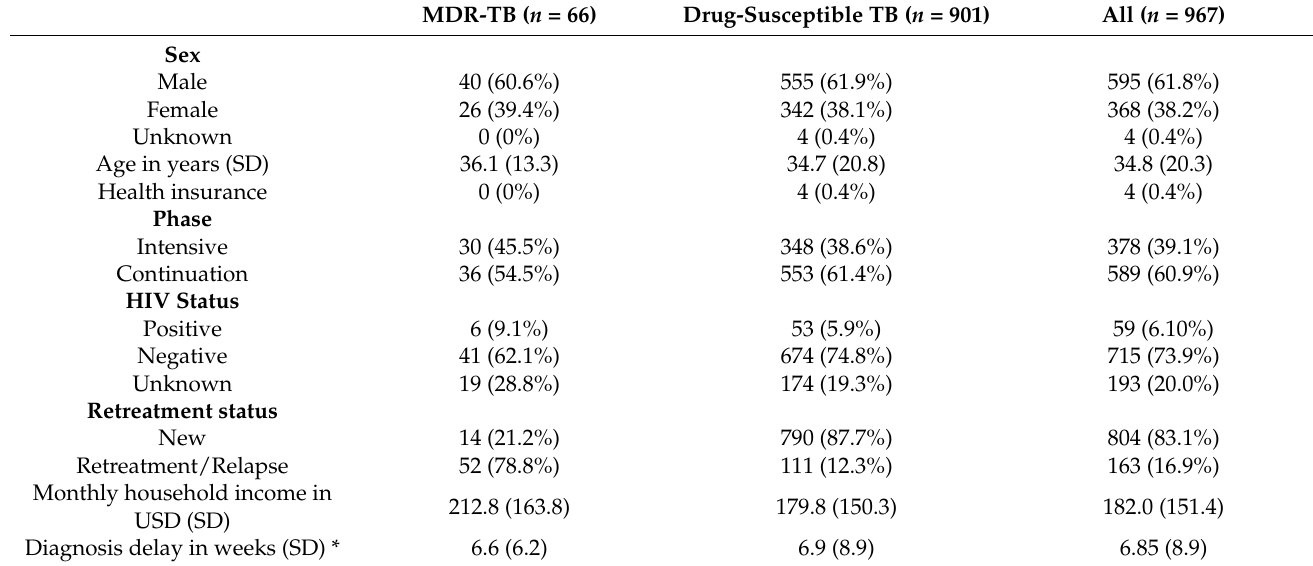
Table 1. Descriptive statistics of survey sample by MDR status and overall.